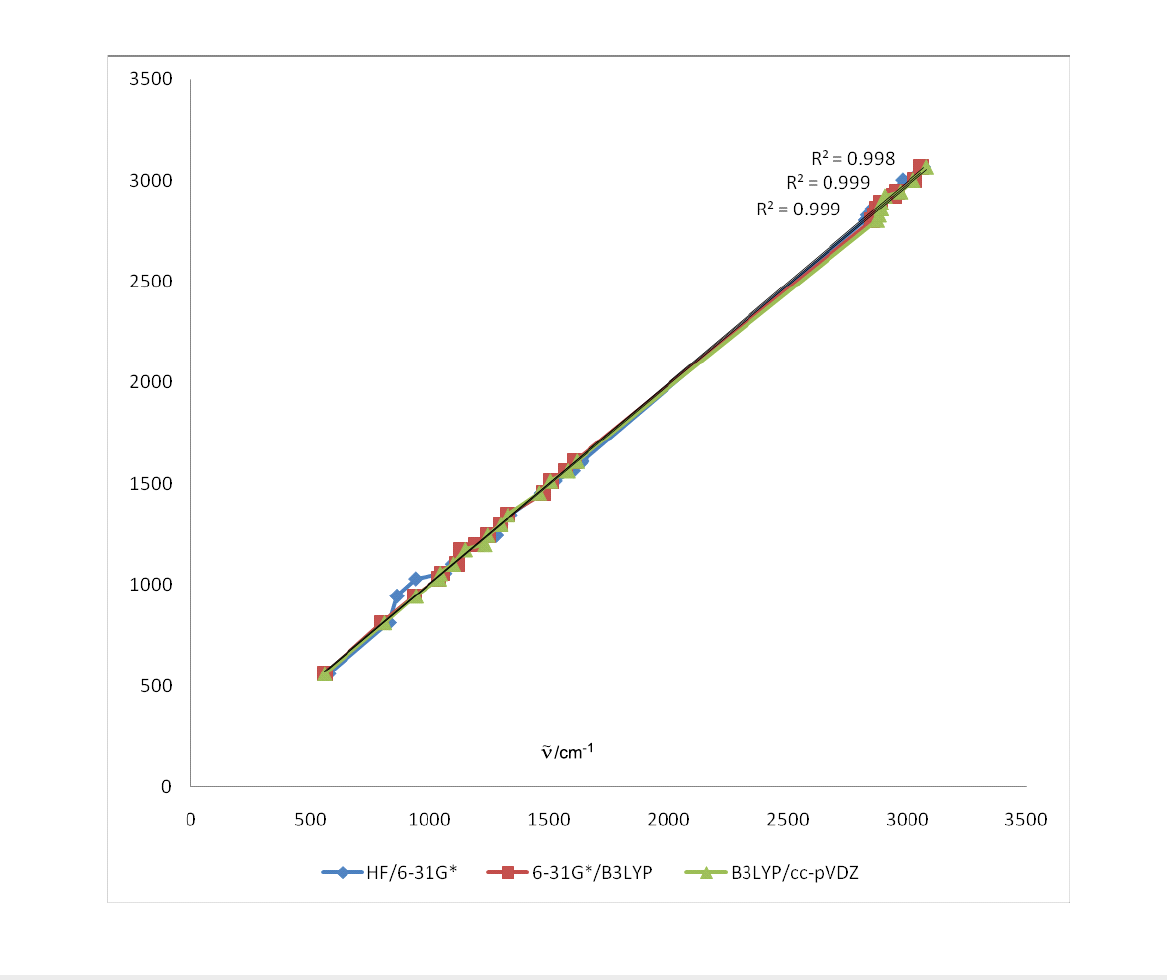
Figure 4: Linear correlation between the experimental and the theoretical frequencies (cm − 1 ) obtained by HF/6-31G*, 6-31G*/B3LYP/cc-PVDZ